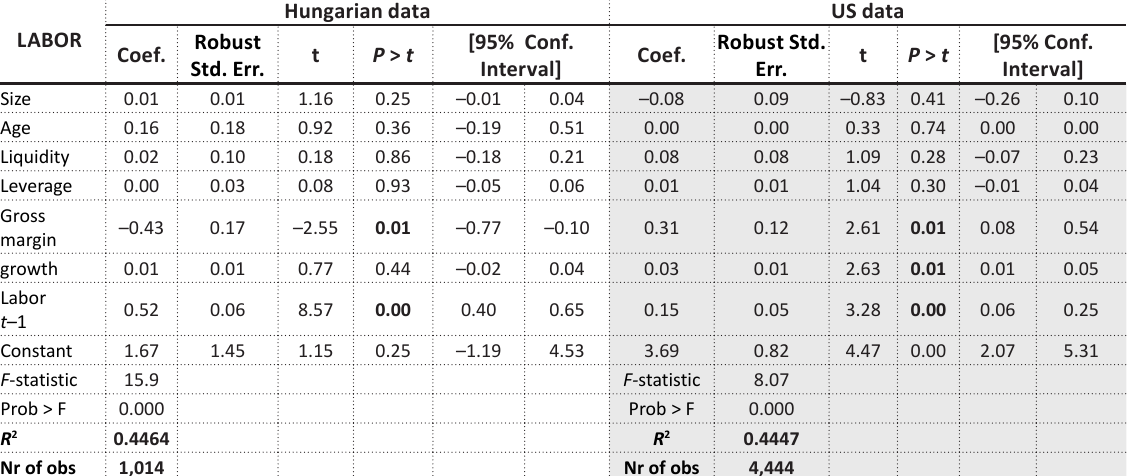
Table 7. Results of the fixed effect panel regression, 2nd model, dependent variable: LABOR Hungarian data US data LABOR Coef.